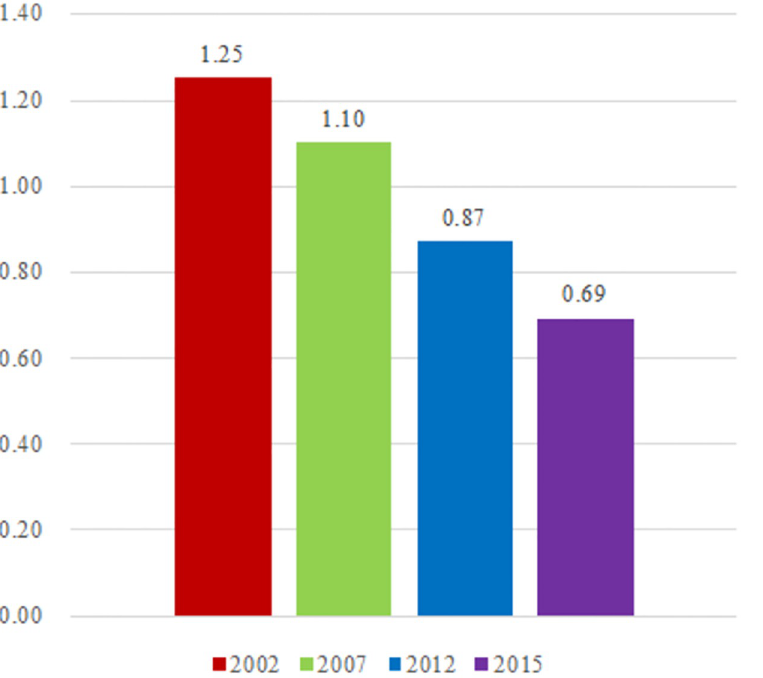
Fig 3. The evolution of industrial carbon emissions